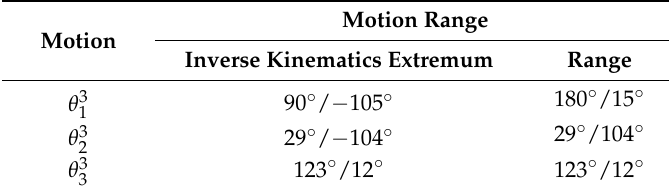
Table 7. Inverse kinematics extremum of the 3-DOF upper-limb exoskeleton.